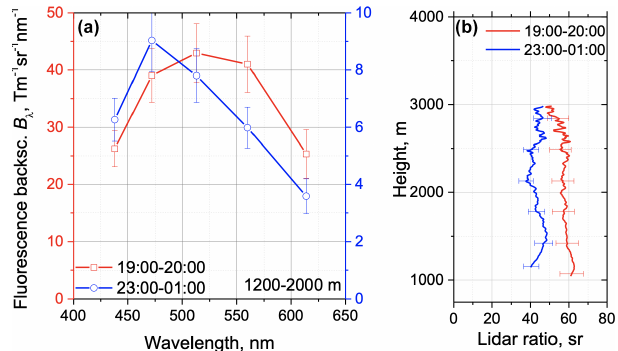
Figure 5. (a) Spectrum of fluorescence backscattering B λ on the night of 27–28 August 2022 for the 19:00–20:00 and 23:00– 01:00UTC intervals. Results are averaged inside the 1200–2000m height range. (b) Profiles of lidar ratios at 355nm for the same tem- poral intervals.